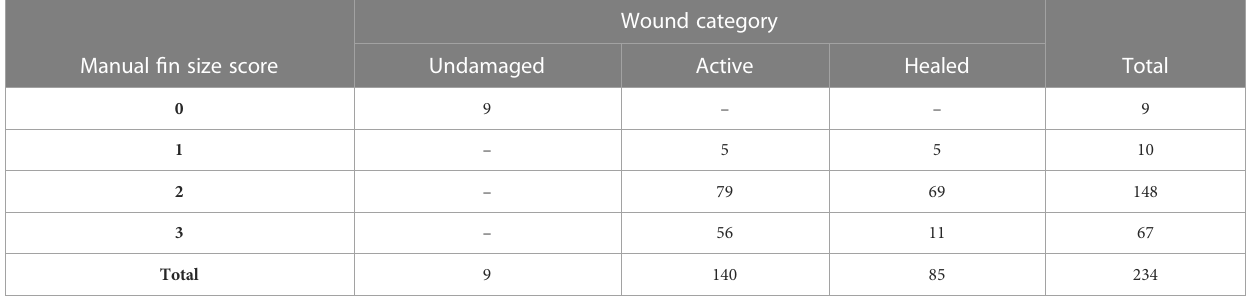
Manual fi n size